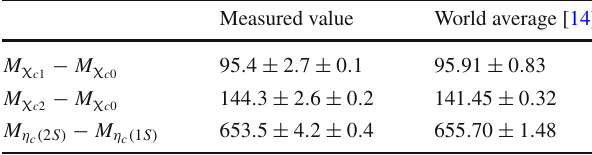
Table 6 Charmonium mass differences (in